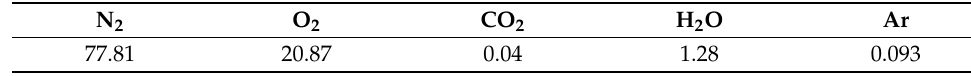
Table 4. Assumed air composition,